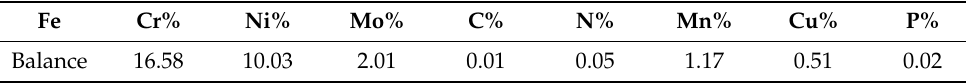
Table 4. Chemical composition of base material for CM parts and specimens.